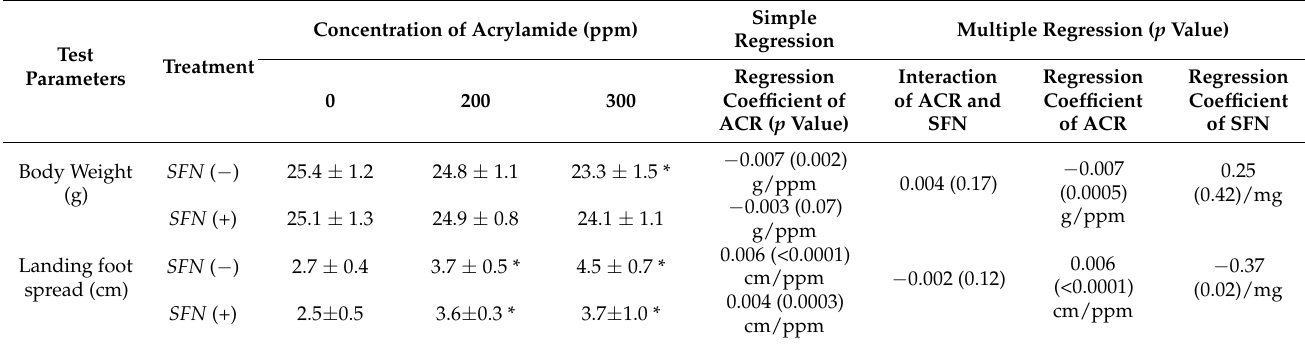
Treat- Test Parameters ment Table 1. Changes in body weight and landing foot spread according to the dose of acrylamide and sulforaphane treatment.